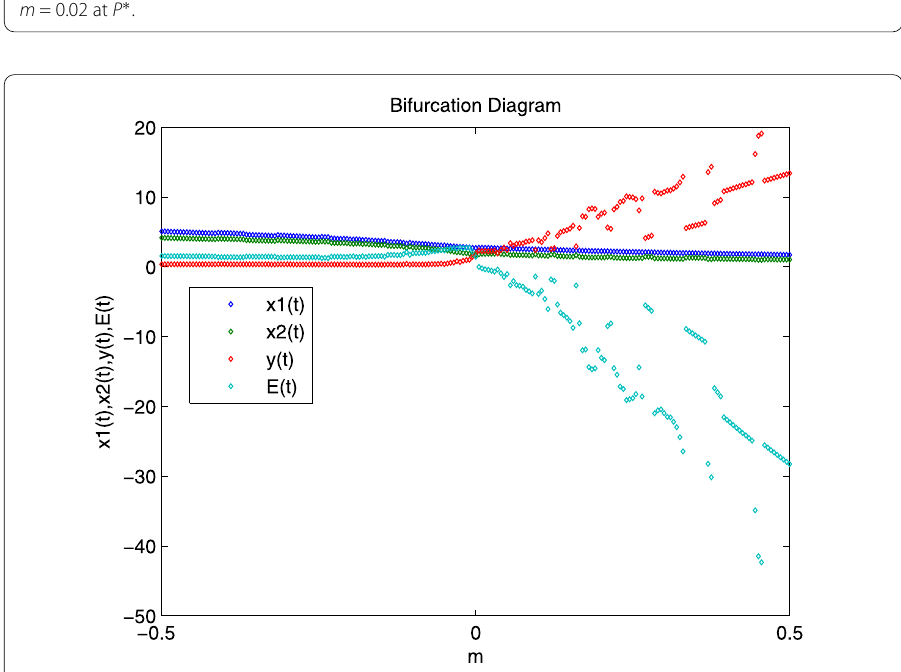
Figure 7 The bifurcation diagram of system (17) with m = 0 at P ∗ . The bifurcation diagram of system (17) with m = 0 at P ∗